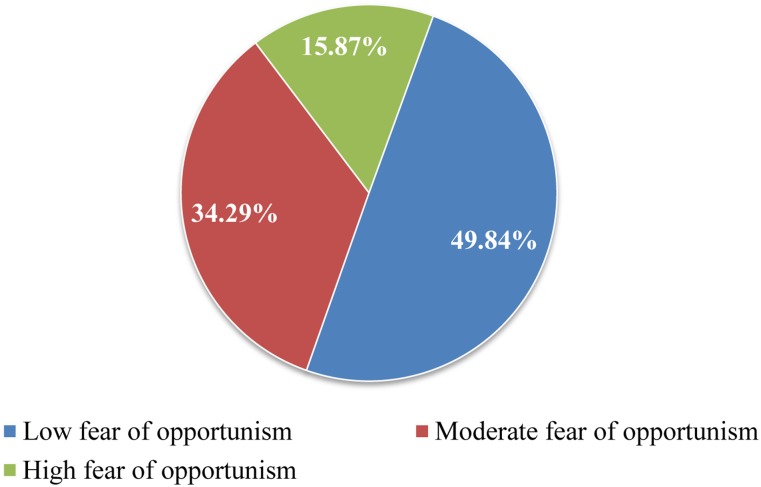
Pie chart illustrating proportion of fear of opportunism levels among contest participants.Respondents in the low, moderate and high fear of opportunism groups consisted of participants that had an average rating within the ranges of “3 or less”, “from 3 to 5” and “5 or more” in the fear of opportunism scale, respectively.